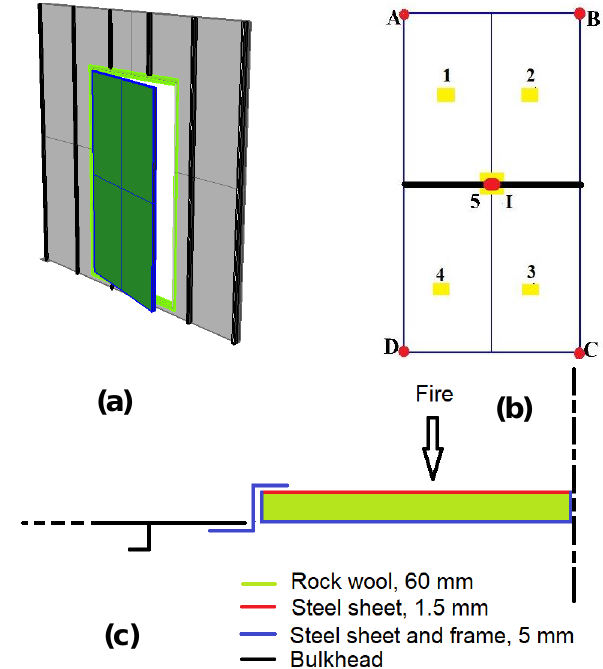
Figure 1. ( a ) Door model geometry; ( b ) test measuring points: thermocouples location (1, 2, 3, Figure 1. (a) Door model geometry; (b) test measuring points: thermocouples location (1, 2, 3, 4, 5) 4, 5) and displacements measuring points (A, B, C, D, I); ( c ) door section with thickness of the and displacements measuring points (A, B, C, D, I); (c) door section with thickness of the components components specified.